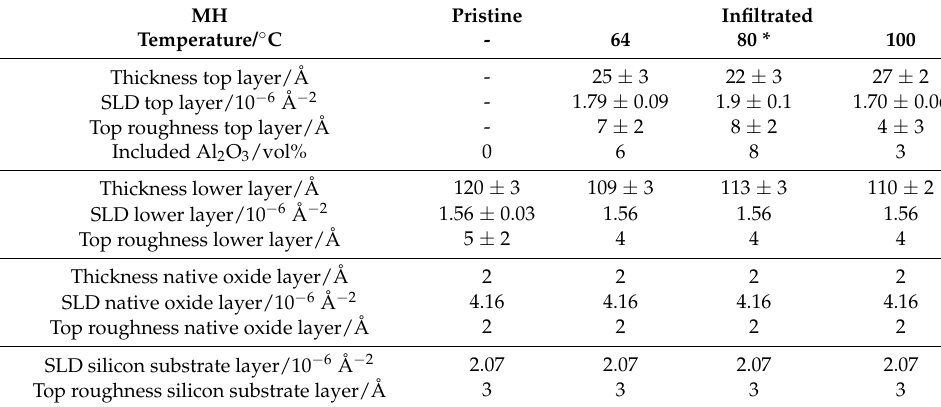
Figure 3. Neutron reflectometry data, showing effect of temperature in semi-static infiltration of TMA/H 2 O into MH. ( a ) Neutron specular reflectivity profiles, showing measured data with error bars, and fitted models as solid lines, and ( b ) fitted neutron SLD as a function of distance from substrate, where z = 0 represents the interface between silicon and native oxide. Table 3. Effect of temperature in semi-static infiltration of TMA/H 2 O into